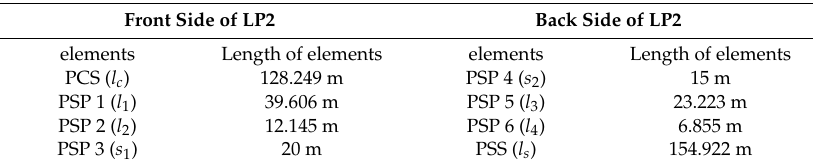
Table A2. The unknown lengths of each element.